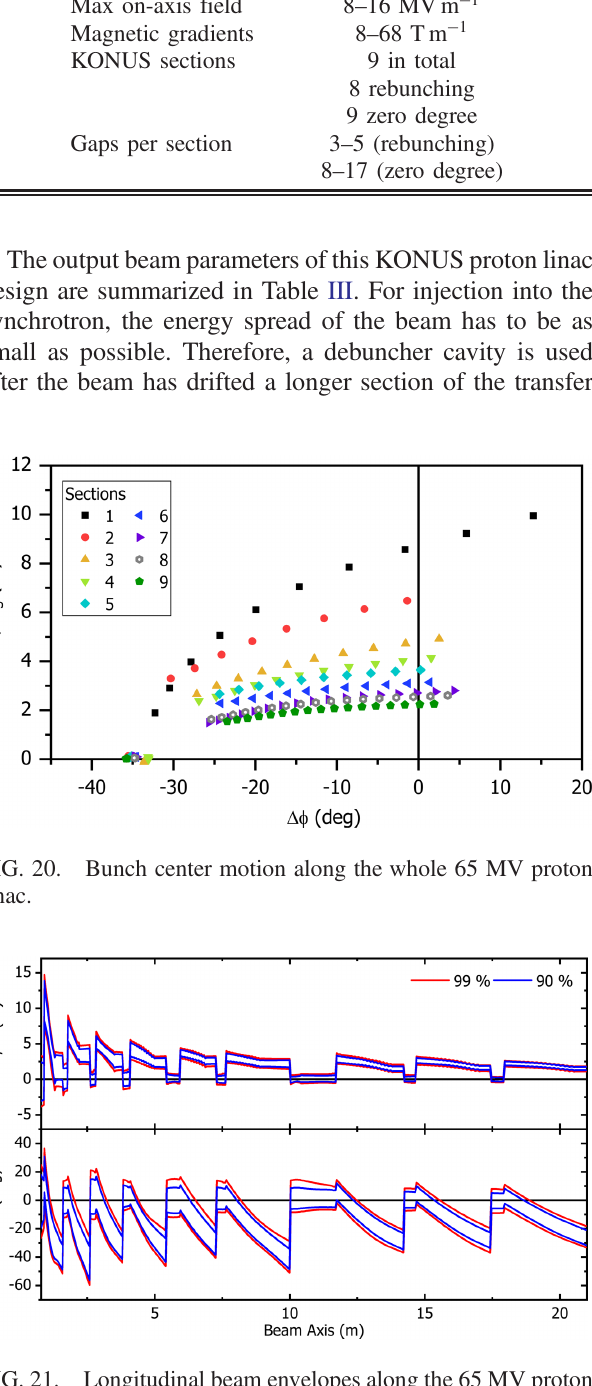
FIG. 21. Longitudinal beam envelopes along the 65 MV proton DTL. The envelopes are shown relative to the synchronous particle to illustrate the KONUS beam